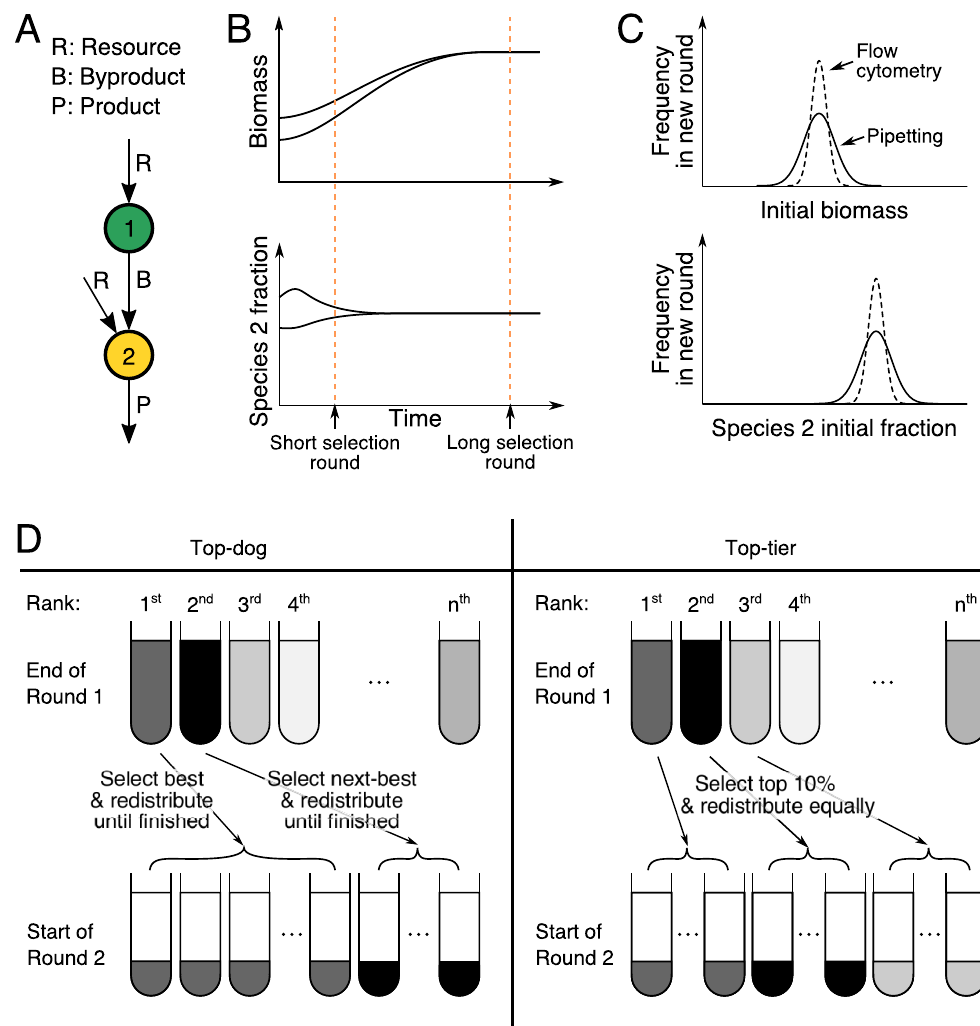
Fig 3. Xie and colleagues optimize community selection. (A) Their system is as follows: species 1 takes up resource R and makes by-product B, whereas species 2 takes up R and B to make the product of interest P. (B) For this system, the amount of product P a community produces is a function of biomass concentration: a community starting with greater biomass will make more product if selection rounds are short. Lengthening the selection round makes sure a community is evaluated by how much its cells produce individually rather than by how much biomass it has accumulated. Similarly, the initial fraction of species 2 affects community score if one selects early but not late. (C) Because of noise in initializing new communities, communities vary in their initial biomass and the fraction of species 2. The plots show the distribution of communities in a given round. Using flow cytometry reduces the noise compared with pipetting. Less noise means less bias in the resulting community scores because of these initial states. (D) Two selection methods were compared. In “top-dog” selection, the best-scoring community from the previous round is distributed among the fresh tubes of the next round until no cells are left, then the next best community is distributed, etc. The best community is highly favored. The “top-tier” selection method is less stringent because all top 10% of communities are equally distributed among the tubes of the next round. This second selection method worked better in Xie and colleagues’